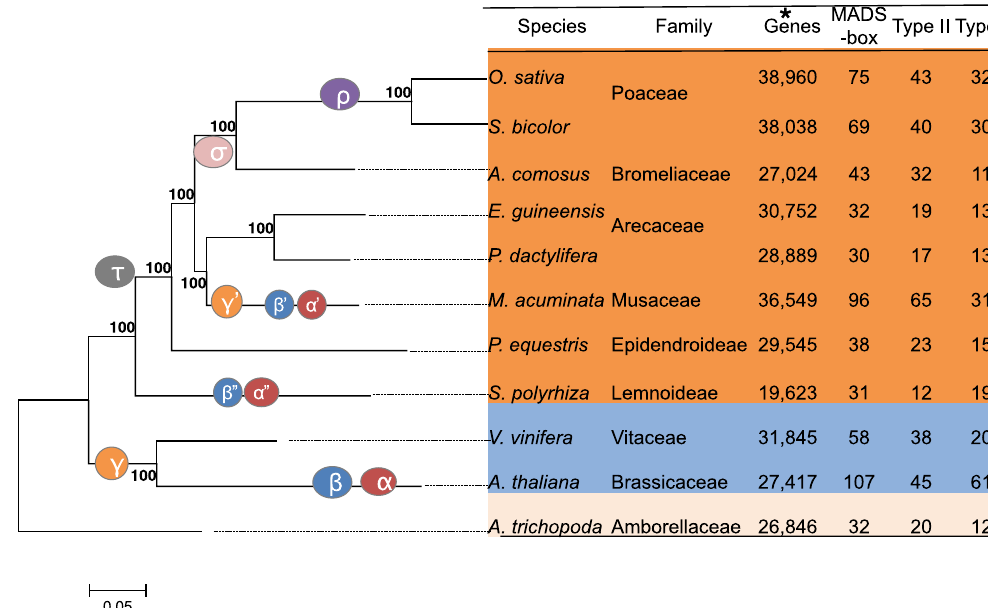
Figure 2. The phylogenetic tree and MADS-box gene numbers of pineapple and ten other species in the context of angiosperms. The ML phylogenetic tree of 11 species was constructed using 756 single-copy genes by orthfinder 24 . *The number of all coding genes in each species. Circles with different Greek letters represent known WGDs identified in previous studies 25–27 . The MADS-box gene number in each species and the classifications were based on the phylogenetic tree (Supplementary Figure